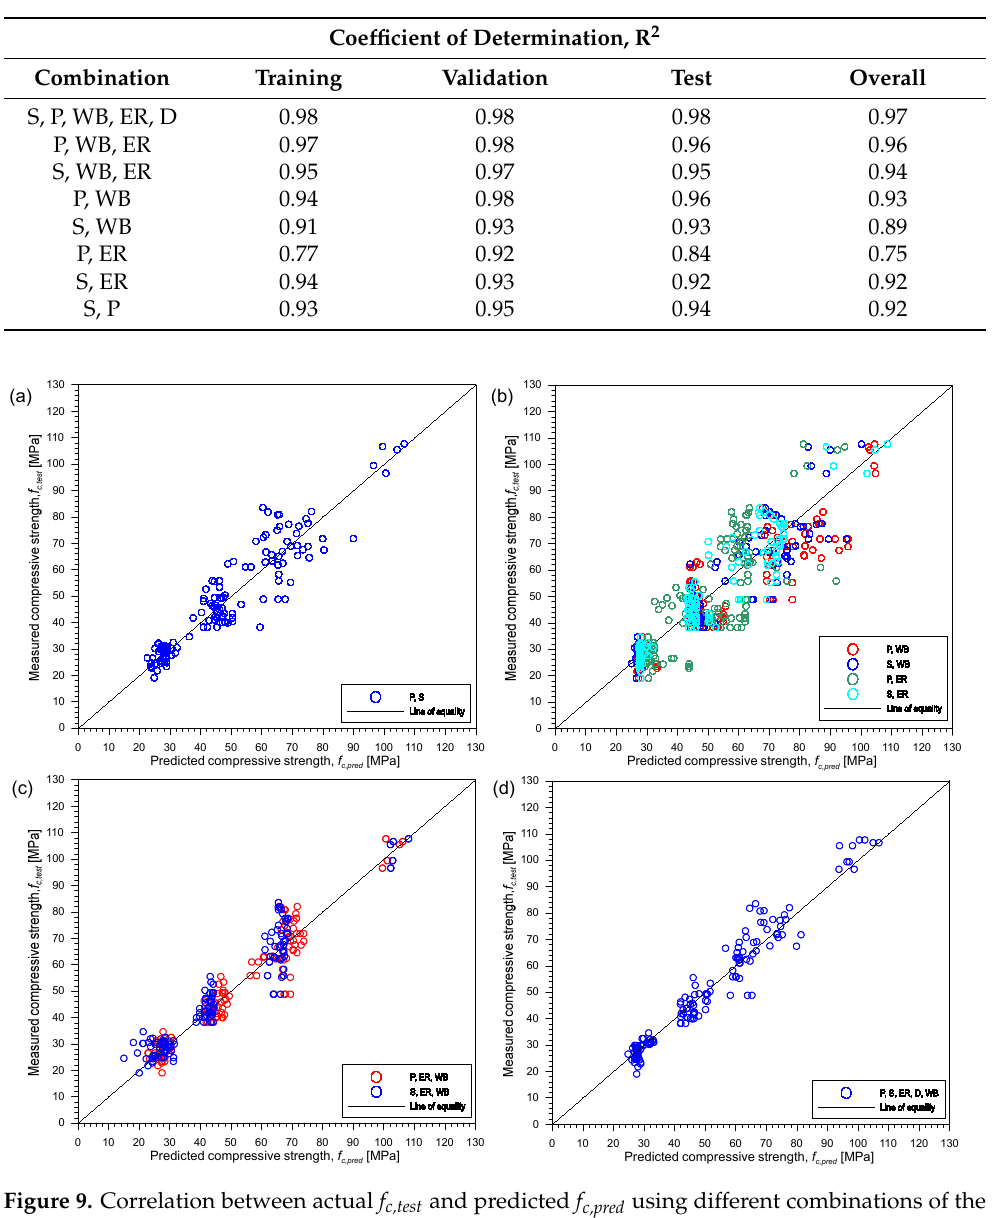
Figure 10. Sample parameter optimization using LM algorithm training: ( a ) 2 parameters, ( b ) 3 pa- rameters and ( c ) 5 parameters.